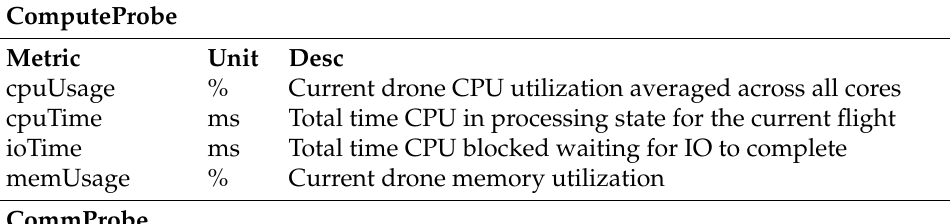
Table 1. FlockAI monitoring probes and